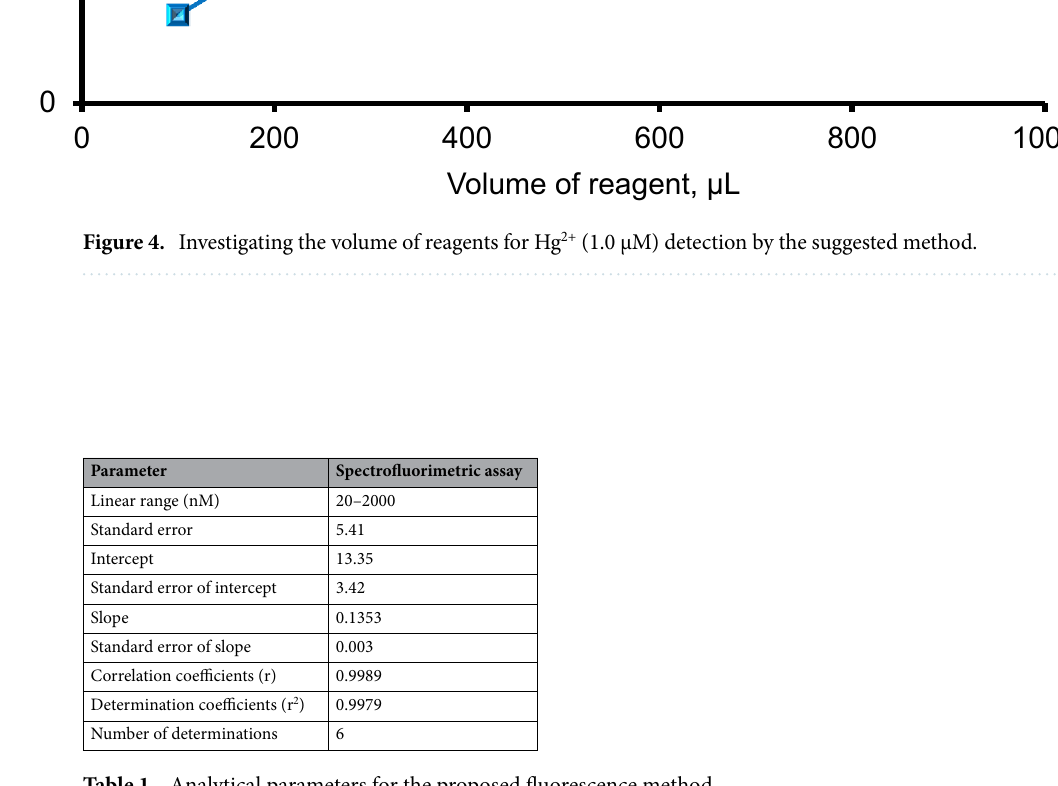
Table 1. Analytical parameters for the proposed fluorescence